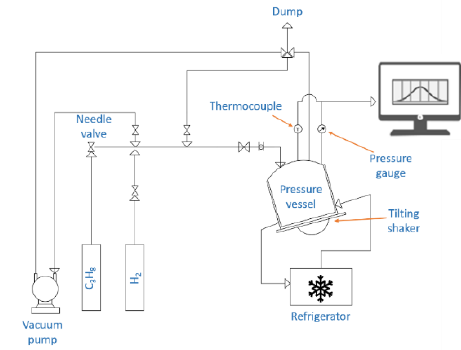
Figure 2. Schematic of the gas-hydrate rig. The four main sections are gas supplier, distribution terminal, reactor and refrigerator.